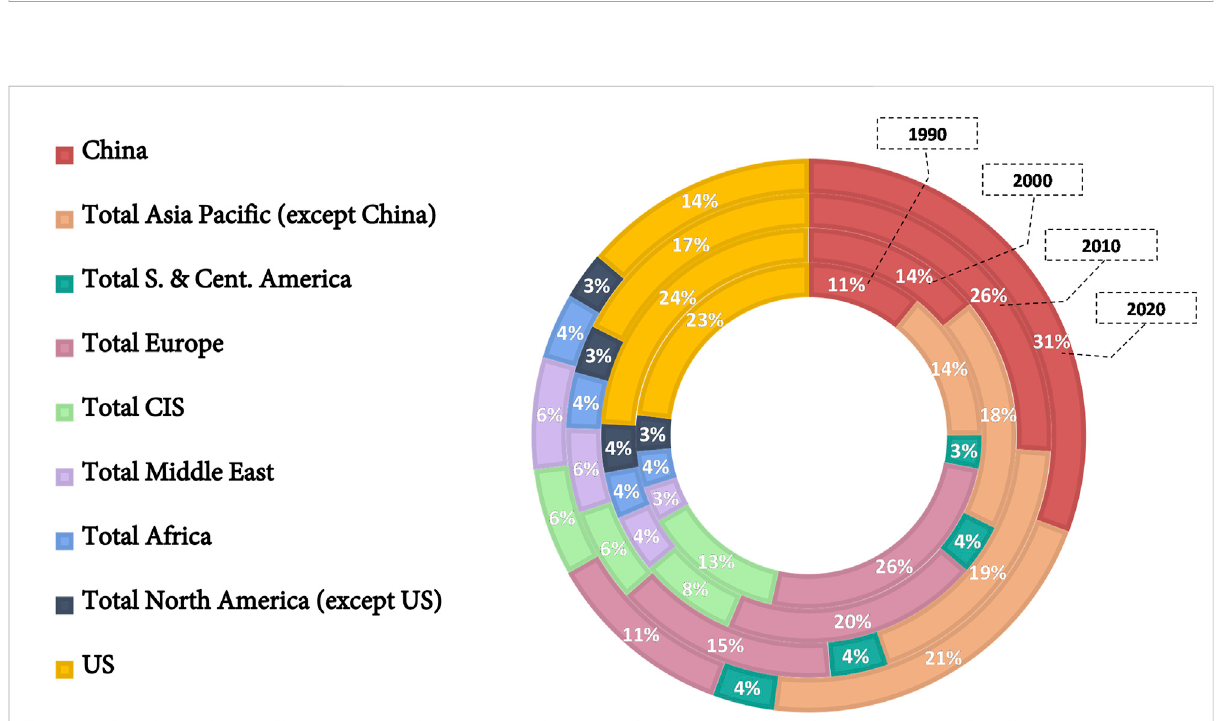
FIGURE 2 Global share of carbon dioxide emissions by region in 1990, 2000, 2010, and 2020. Data source: